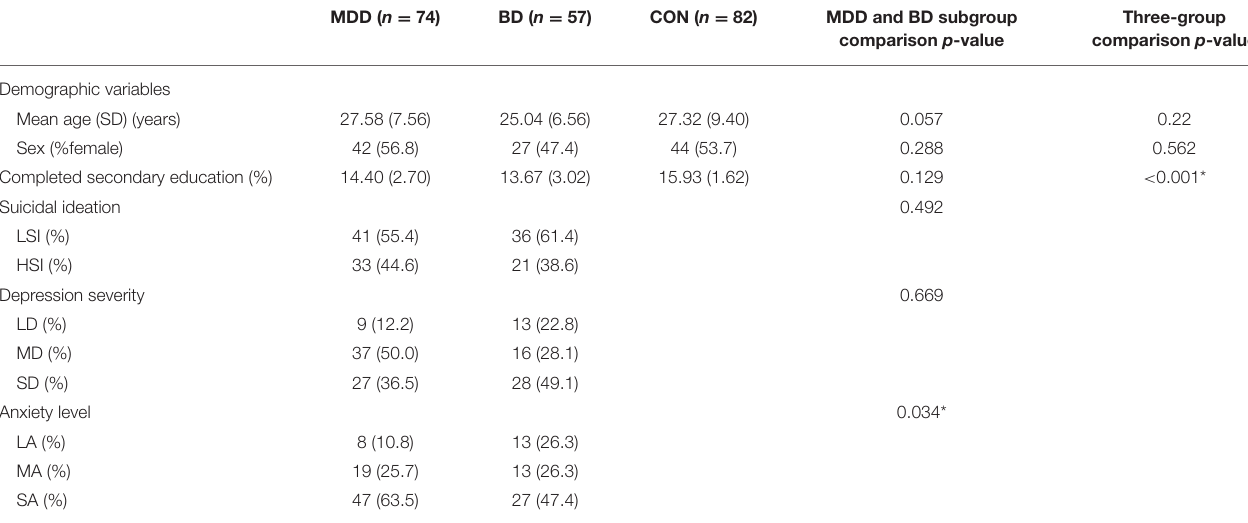
TABLE 1 | Clinicopathological information of subjects for the plasma hypocretin-1 level study.